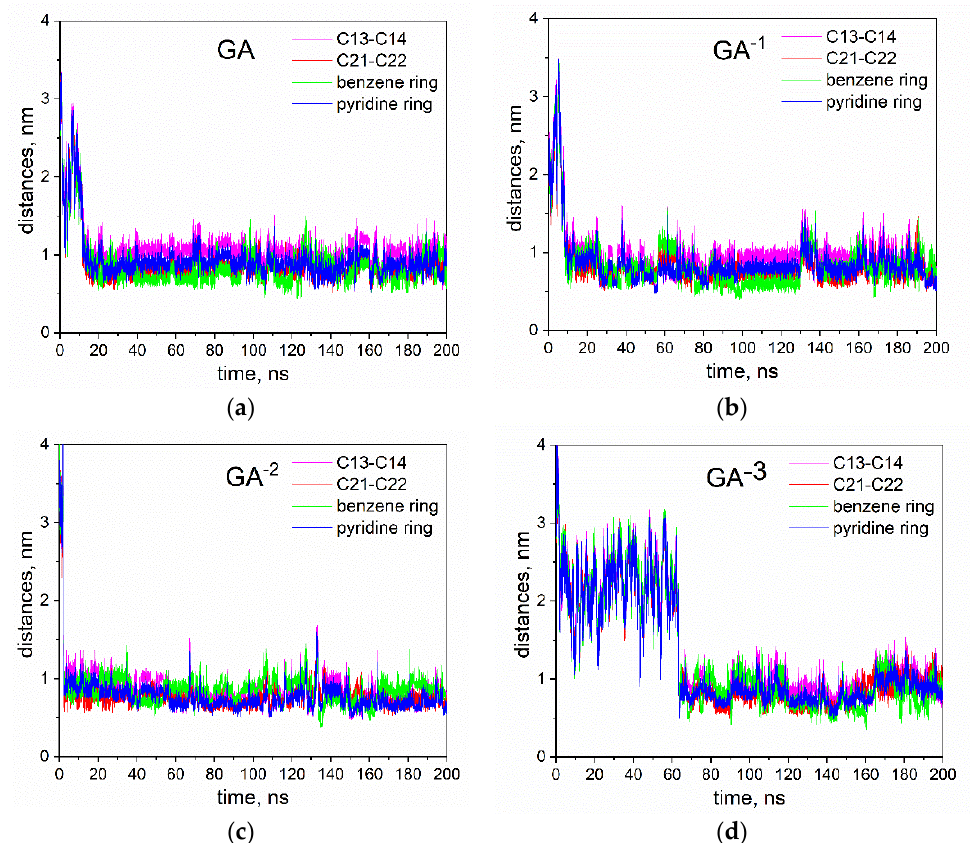
Figure 8. Distances between different moieties of the nifedipine molecule and the COM of different GA ions per simulation time ( a ) GA (fully protonated), ( b ) GA 1 − , ( c ) GA 2 − , ( d ) GA 2 − . Colors for different moieties are taken from Figure 7.